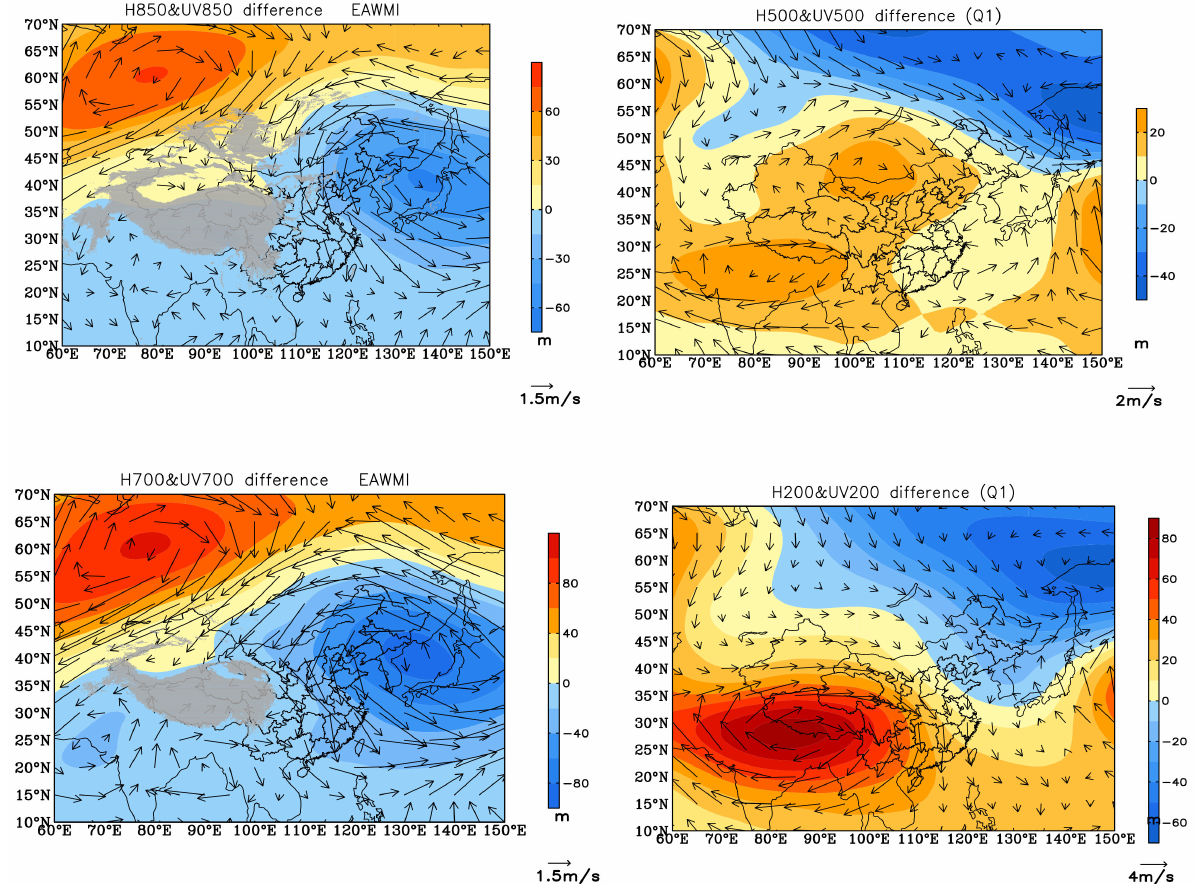
Figure 2. Wind and geopotential height at 850 hPa ( upper left ) and 700 hPa ( bottom left ) in strong and weak winter monsoon years; wind and geopotential height in strong and weak cold source years on the Tibetan Plateau at 500 hPa ( top right ) and 200 hPa ( bottom right ) (shaded areas are terrain corresponding to